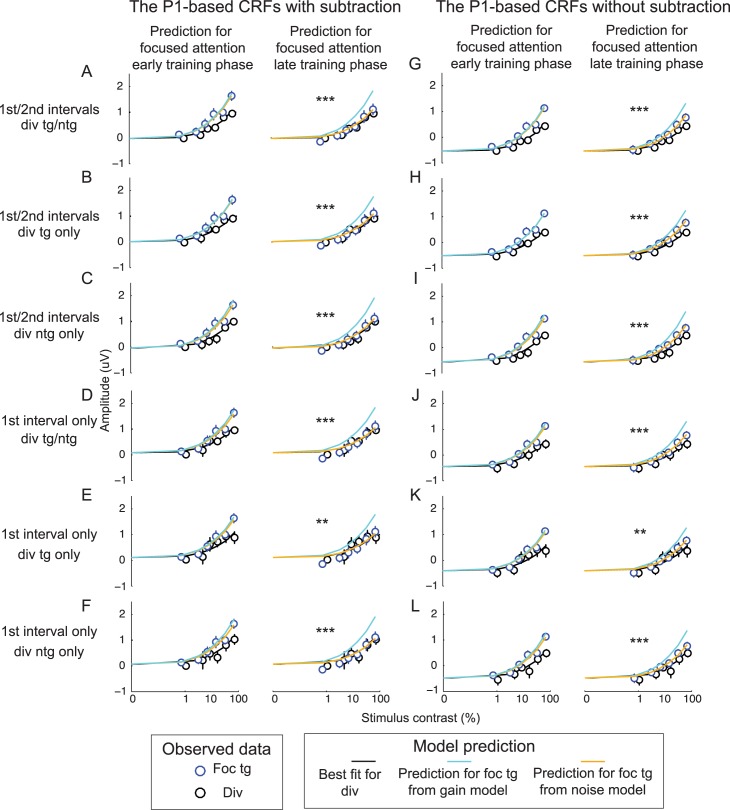
Linking changes in the psychophysical data and the P1 data using gain and noise models.A quantitative model based on signal detection theory (SDT) revealed that, early in training, attention-induced improvements in behavioral performance were sufficiently explained by the gain model, and the noise model did not significantly improve the fit (left panels in all subfigures). However, later in training, the noise model provides a significantly better prediction than the gain model (right panels in all subfigures). The modeling results are consistent across all modeling routines in which the P1-based contrast response functions (CRFs) in the divided attention condition were obtained from the average between the divided target and divided nontarget conditions (A, D, G, and J), from the divided target condition only (B, E, H, and K), from the divided nontarget condition only (C, F, I, and L), from the average between 2 stimulus intervals (A–C and G–I), and from the first stimulus interval only (D–F and J–L). Last, (A–F) show data with the baseline subtraction and (G–L) show data without baseline subtraction. ** and *** represent significant improvements with the noise reduction model p < 0.01 and p < 0.001 (false discovery rate [FDR]-corrected). See corresponding model parameters in Tables 1 and 2. Data are available from the Open Science Framework (https://osf.io/pc7dr/).